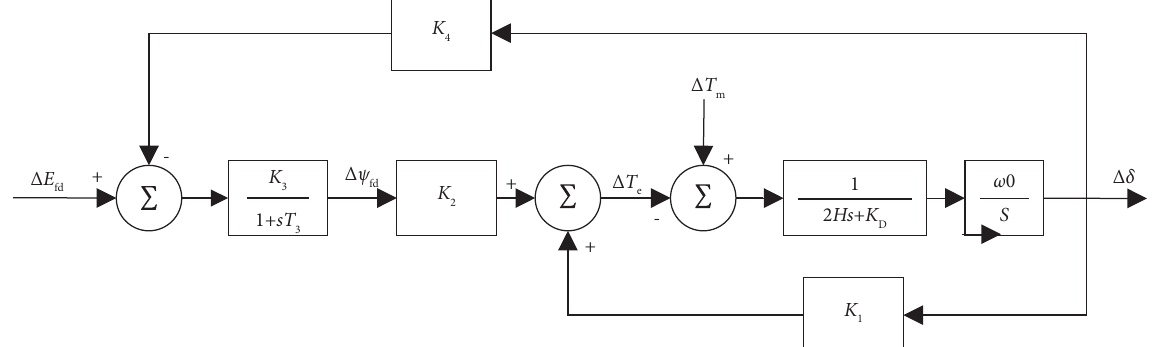
Figure 4: Control framework of single infnity system with constant excitation